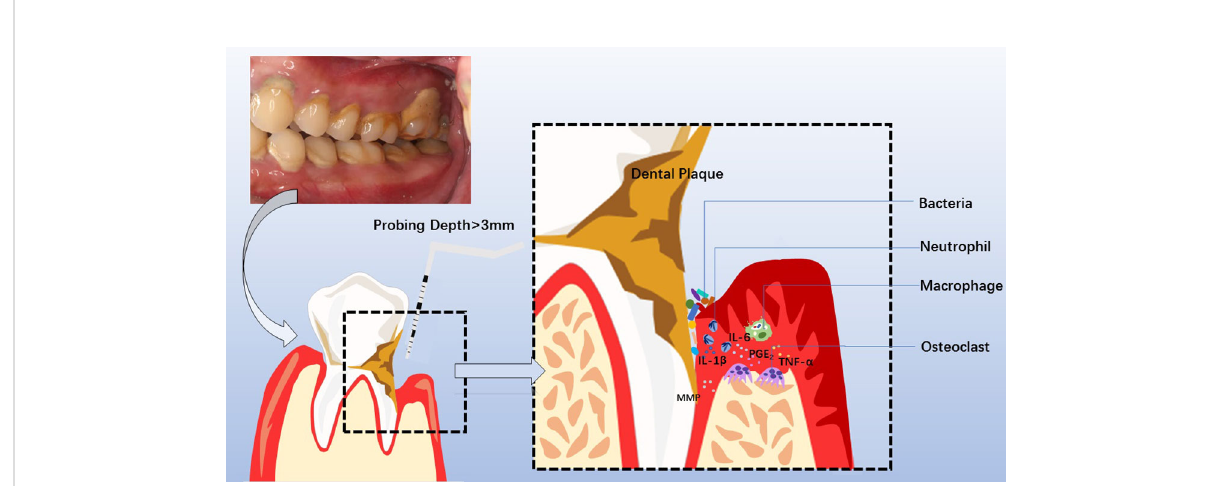
FIGURE 2 Clinical manifestations, diagnosis, pathogenesis of chronic periodontitis, and involved cytokines and cells. Periodontitis is manifested clinically by swollen, bleeding gums, breath malodor, and deep periodontal pocket. At the diseased sites, the probing depth of the deep periodontal pocket is more than 3mm, with bleeding on probing or periodontal pyorrhea. Dental Calculus and dysbiotic dental plaque at the cervical tooth extend to the bottom of the gingival sulcus or periodontal pocket, facilitating pathogens to invade the sulcular epithelium and junctional epithelium. Subsequently, neutrophils and macrophages are recruited to the diseased sites, releasing MMP, PGE2, IL-1 b , IL-6, TNF- a , et al. The overactivated in fl ammatory response causes periodontal tissue destruction, including collagen degradation and resorption of the supporting alveolar bone mediated by osteoclast. Consequently, the development of a deep periodontal pocket increases tooth mobility until